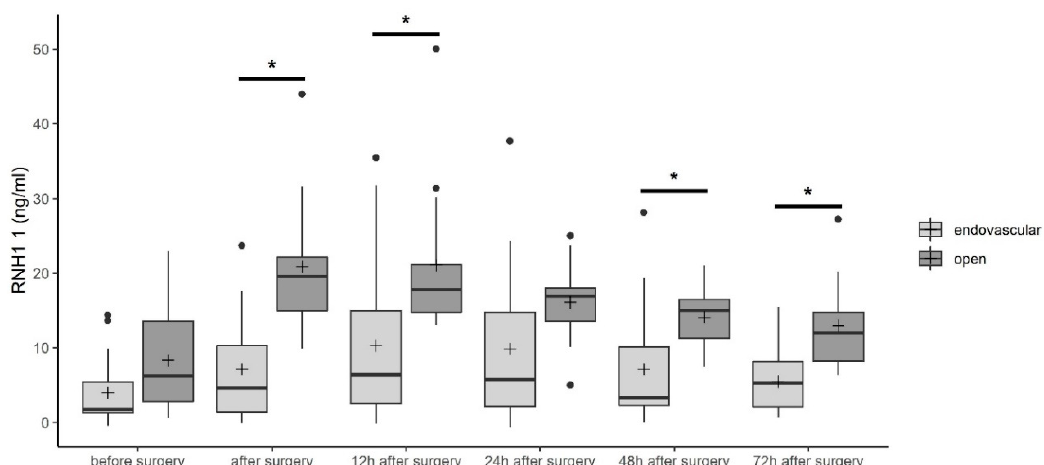
Figure 3. RNase inhibitor 1 (RNH1) serum levels in patients undergoing open or endovascular TAAA repair. Data are presented as box-whisker plots. Lines inside the boxes represent the median and the pluses represent the mean. The box is defined by Q1 and Q3. The whiskers range from Q1 to Q1 + 1.5 ∗ (Q3 − Q1) and Q3 to Q3 − 1.5 ∗ (Q3 − Q1), with observations outside of the whiskers shown as points classified as outliers. Unpaired t -test (two-tailed) was used for statistical analysis of the two groups. * p < 0.05; RNH1, RNase inhibitor 1.